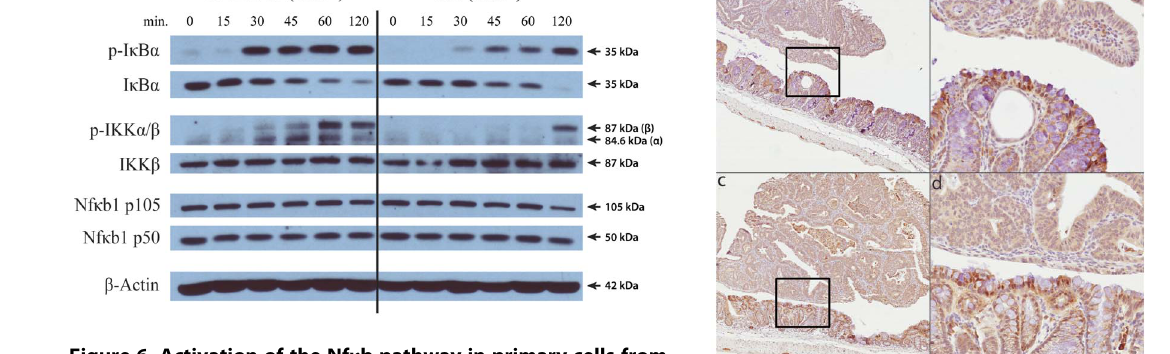
Figure 6. Activation of the Nf k b pathway in primary cells from A/J and C57BL/6J mice. Bone marrow-derived macrophages were prepared from A ( Ccs3 S ) and B6 ( Ccs3 R ) mice and were stimulated in the presence of lipopolysaccharide (LPS). At the indicated time intervals (minutes, shown at the top), cells were harvested, lysed and total protein extracts were prepared. Samples were resolved on 10% SDS- PAGE and analyzed by immunoblotting with antibodies against NF k B (p50, p105), total and phospohorylated (p-)I k B a as well as total and phosphorylated I k B kinases, (p-)IKK a / b and b -actin as loading control. The molecular weight of individual proteins is shown on the right of each assembled panel, each of which is representative of 3 independent experiments.